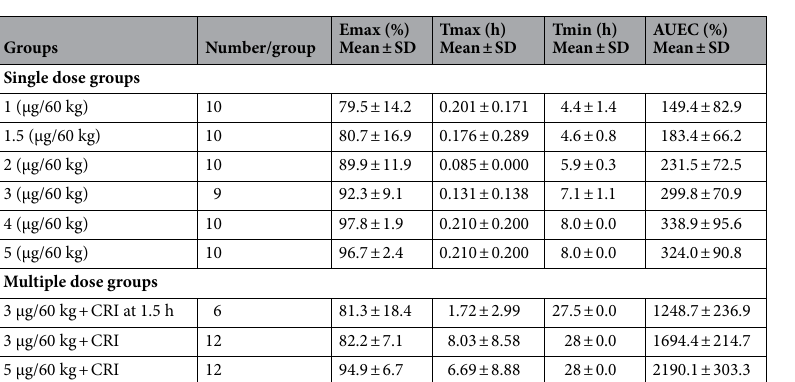
Emax (%) Tmax (h) Tmin (h) AUEC (%) Mean ± SD Mean ± SD Mean ± SD Mean ± SD